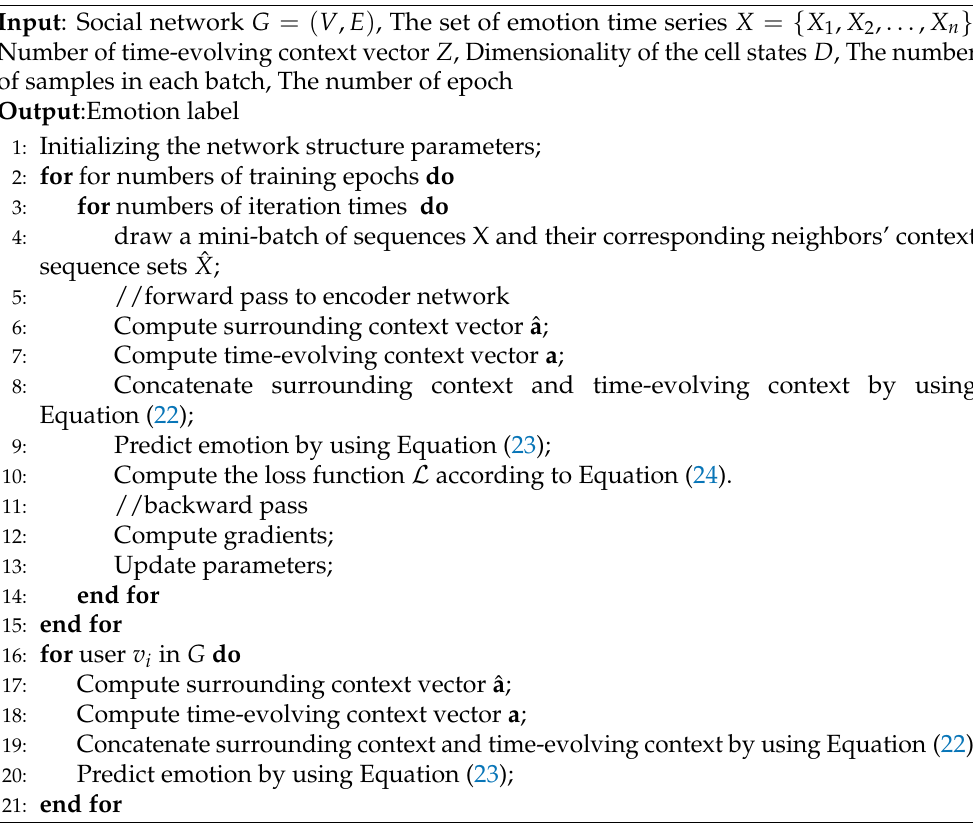
Algorithm 3 Training and prediction algorithm for